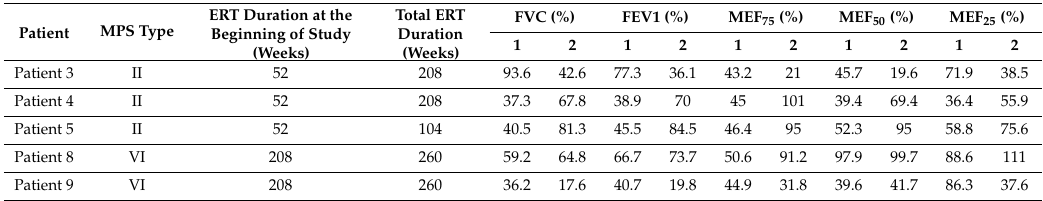
Table 5. Spirometry results (%) of patients with MPS II and VI on